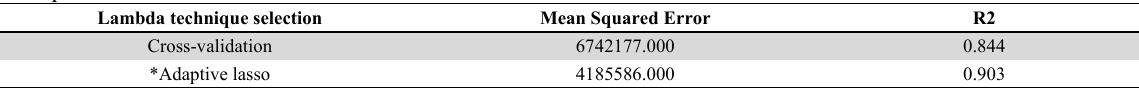
Lasso post-estimation Lambda technique